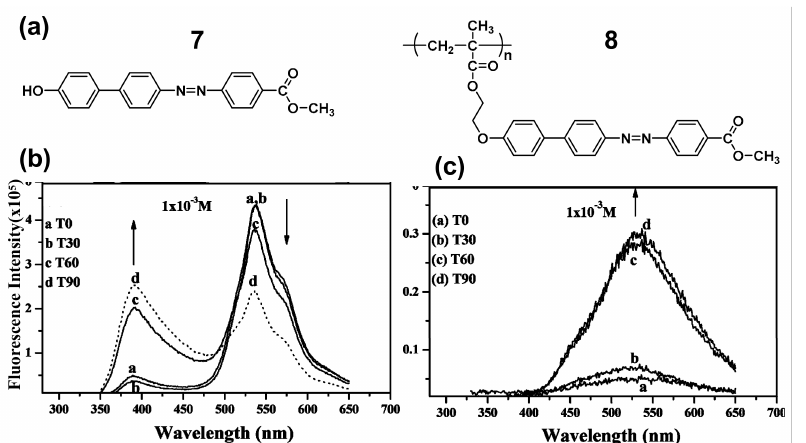
Figure 7. ( a ) The molecular structure of phenylphenol azobenzene and its polymers ( b ) and ( c ) The fluorescence spectra of 7 and 8 upon UV irradiation after various time intervals (0 min, 30 min, 60 min, 90 min). ( b , c ) were reproduced with permission from [60]. Copyright 2007 American Chemical